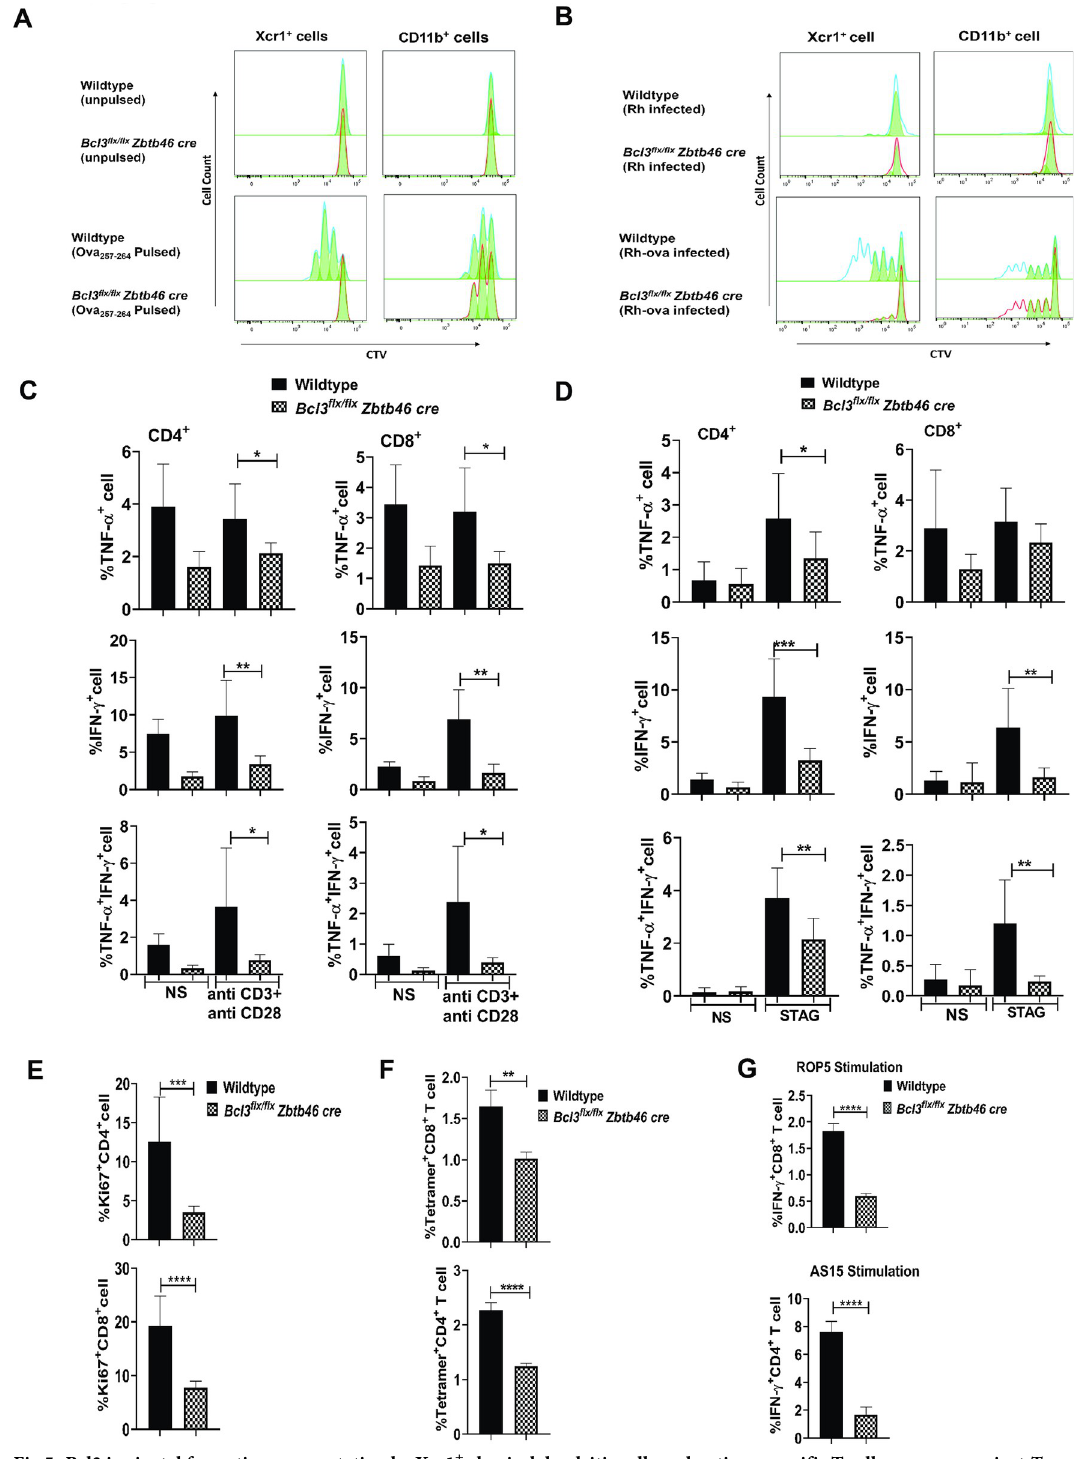
Fig 5. Bcl3 is pivotal for antigen presentation by Xcr1 + classical dendritic cells and antigen-specific T cell responses against T . gondii . (A, B) Bcl3-dependent antigen-specific T cell proliferation. Splenic Xcr1 + and CD11b + cells were isolated from naive wildtype and Bcl3 flx/flx Zbtb46 cre mice. Cells were pulsed with class I (Kb)-restricted Ova 257-264 peptide for 3 hours (A) or infected with ovalbumin-expressing T . gondii (designated Rh control and Rh-ova) for 24 hours (B). Finally, they were cocultured with Cell tracer violet-stained OT-I T cells for an additional 72 hours. T cells were analyzed by flow cytometry and the proliferation profile for CD8 + T